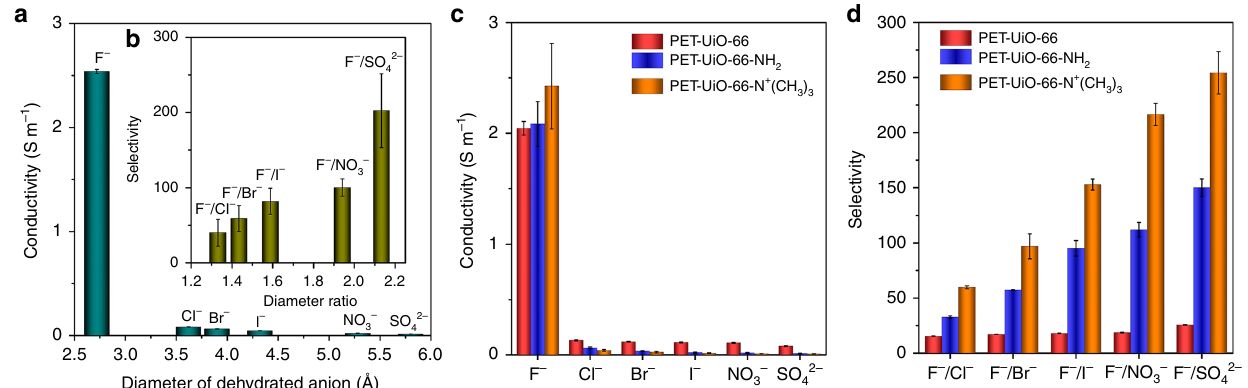
Fig. 6 F − selective properties of PET-UiO-66-X nanochannels. a Ionic conductivities of a PET-UiO-66-NH 2 nanochannel decrease as dehydrated anion diameters increase. b Average ion selectivity as a function of dehydrated anion diameter ratio (Selectivity = k bars represent the standard deviation of independent measurement of three samples. c , d Systematic comparison of ionic conductivities and selectivities of PET-UiO-66, PET-UiO-66-NH 2 , and PET-UiO-66-N + (CH 3 ) 3 nanochannels. The PET-UiO-66-N + (CH 3 ) 3 nanochannel exhibits the highest F − conductivity and selectivity. All data were obtained using 0.1 M electrolyte solutions at a pH value of 5.7. Error bars represent the standard deviation of three measurements of a Supplementary Table 1). In PET-UiO-66-NH 2 nanochannels,